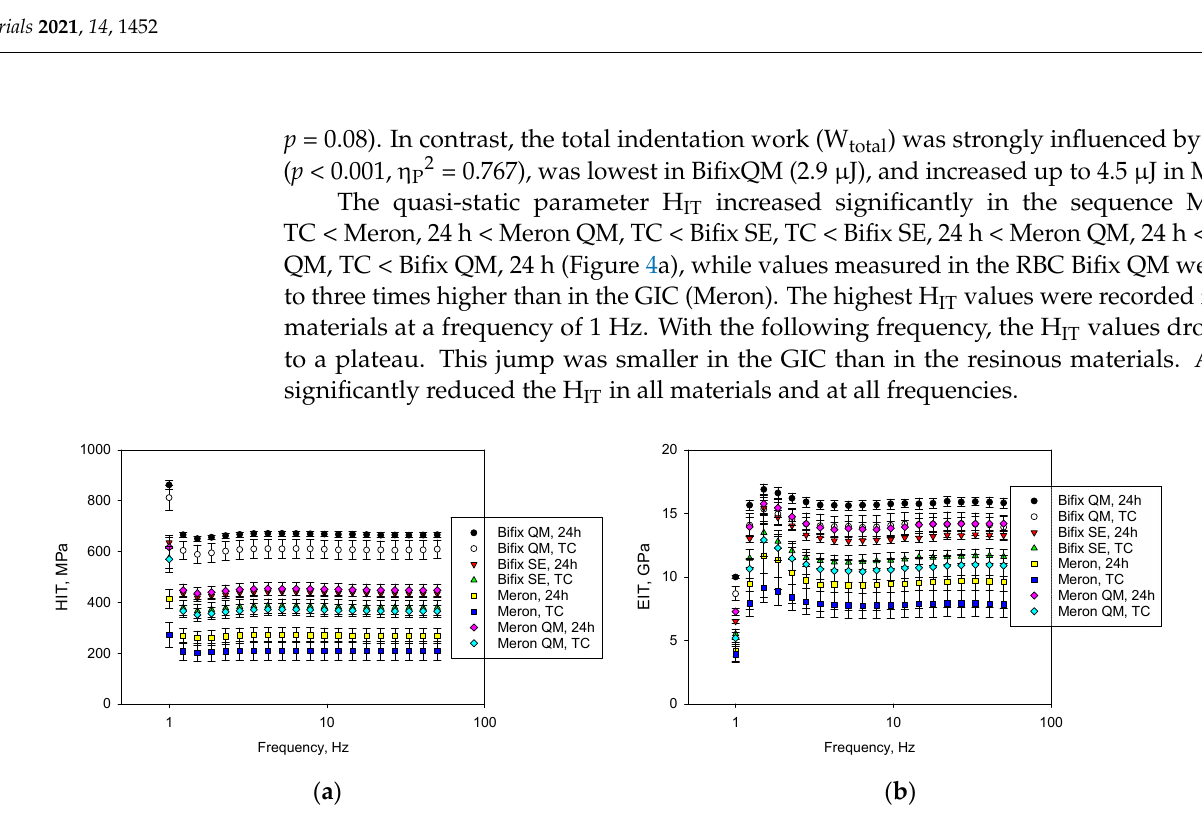
Figure 4. Variation of ( a ) indentation hardness H IT and ( b ) indentation modulus E IT over the frequency range 1–50 Hz for the materials analyzed.